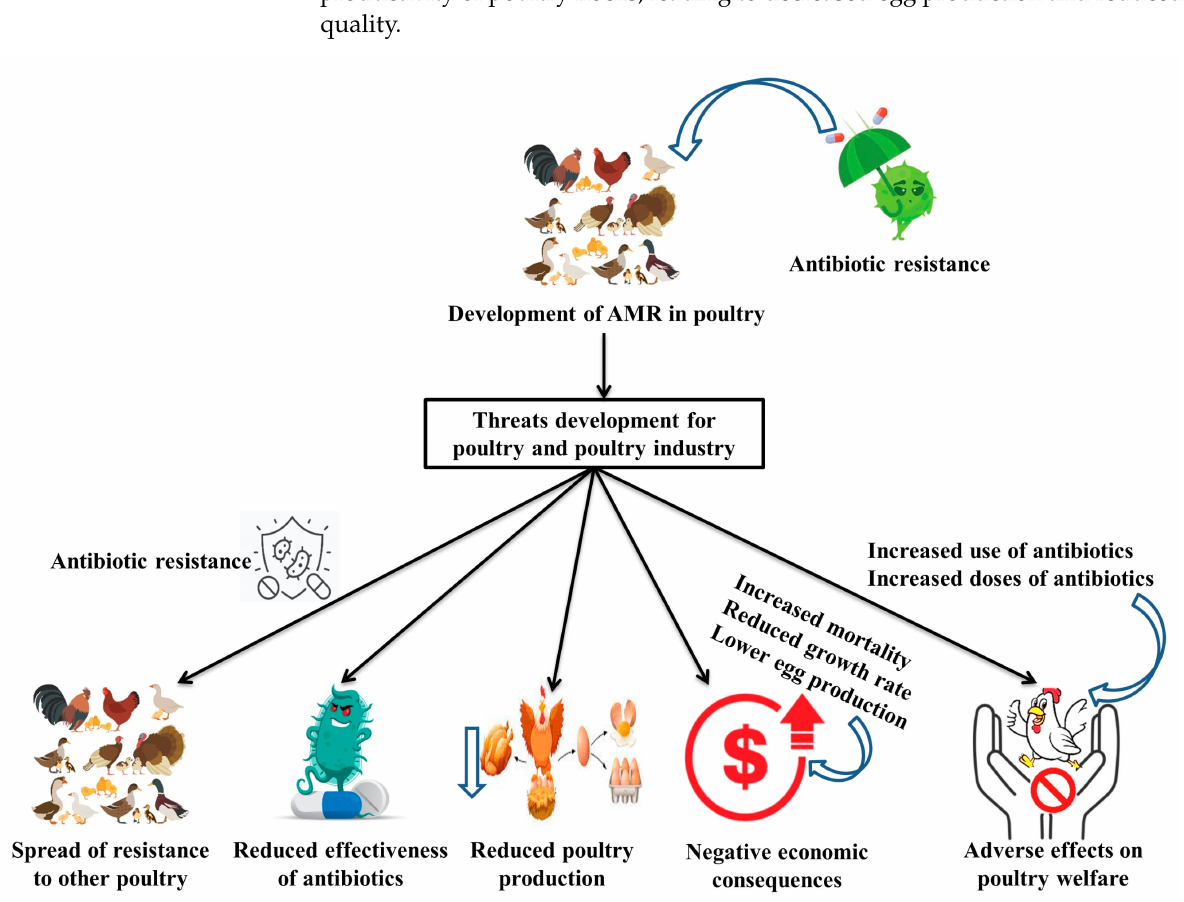
Figure 1. Possible threats of antimicrobial resistance on poultry and poultry